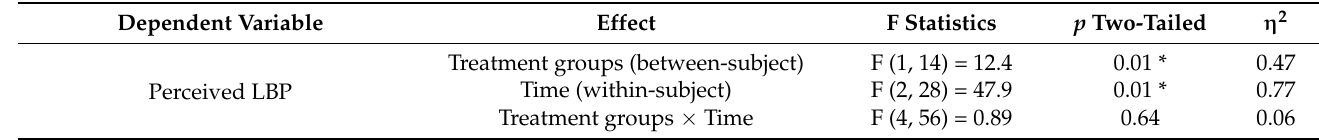
Table 11. Repeated measures ANOVA test results in perceived